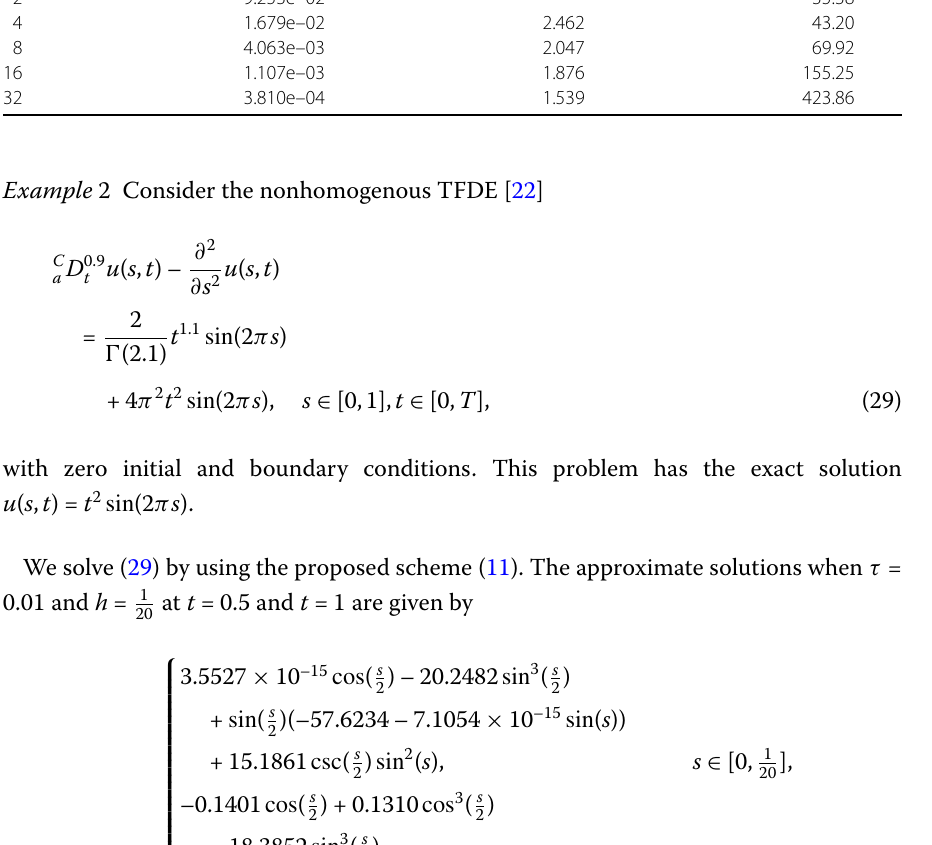
Table 2 Order of convergence for various values of M when τ = 0.001, γ = 0.8 for Example 1 M L ∞ Norm OC CPU Time